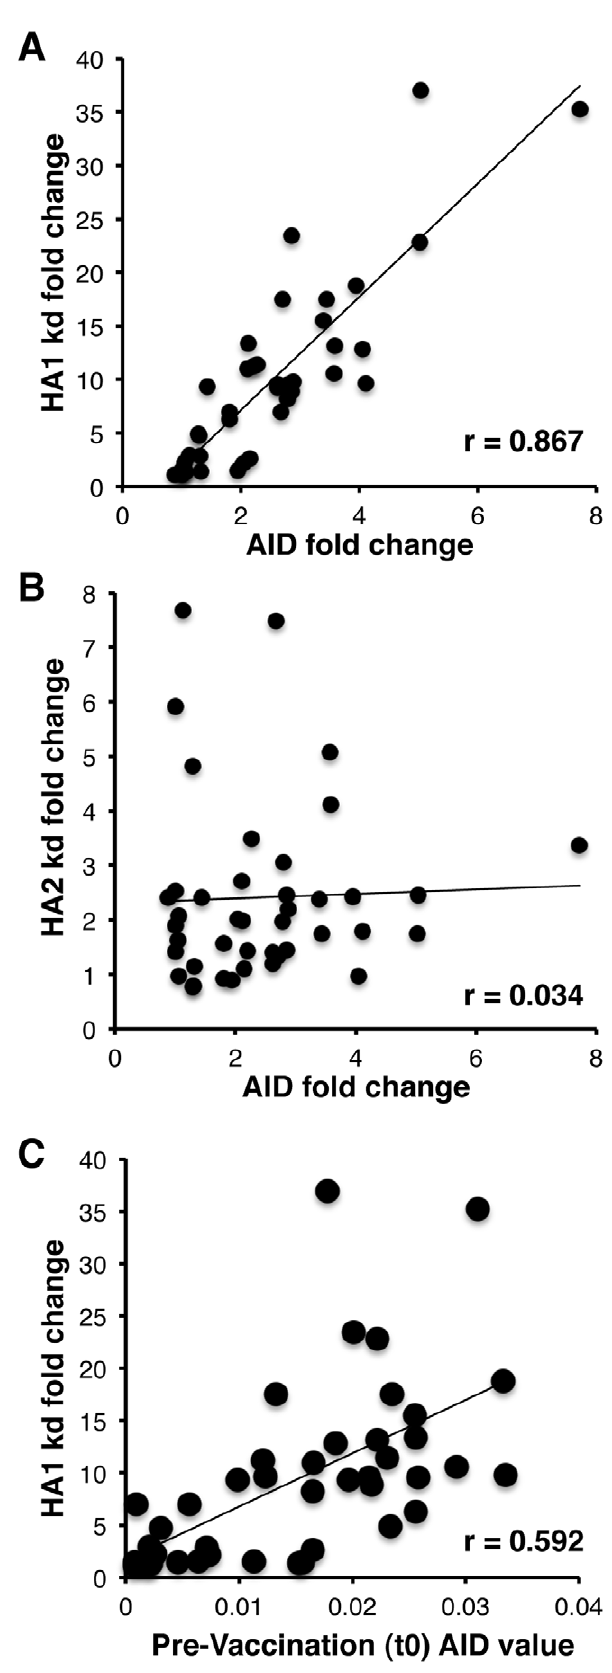
Figure 3. Polyclonal human plasma antibody dissociation rates for HA1 correlate with AID induction in influenza specific B cells. Human polyclonal antibody off-rate constants that describe the fraction of antibody-antigen complexes decaying per second were determined directly from the plasma sample interaction with H1N1pdm09-HA1 (A) and H1N1pdm09-HA2 (B) proteins during the dissociation phase for pre- and post-vaccination samples from each individual. Fold change in plasma antibody off-rate constants (each symbol represents one individual) were determined as described in Materials and Methods. (A) The fold decrease in antibody off-rates following H1N1pdm09 vaccination strongly correlated with AID fold- change. (B) No significant correlation was observed in antibody affinity against HA2 and AID fold change. (C) Positive correlation between AID activity in B cells before vaccination (t0) and fold change in antibody affinity in t28 vs. t0. The off-rate constants were determined from two independent SPR